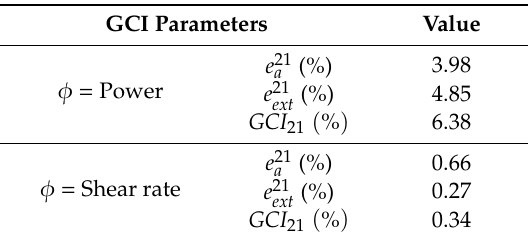
Table 4. GCI parameters result for Brunswick Bioflo / CelliGen 115 bioreactor simulations.